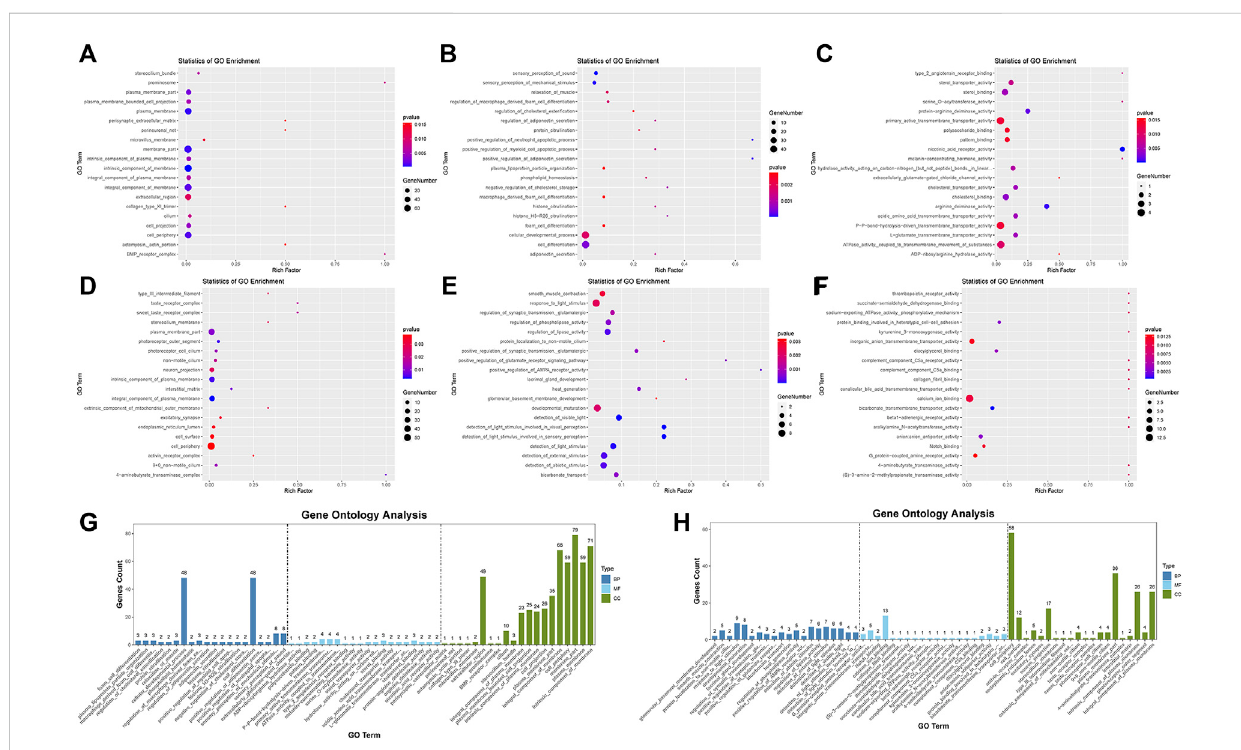
FIGURE 6 Results of gene ontology enrichment analysis. (A,B,C) Scatter plots show the top 20 signi fi cantly enriched gene ontology (GO) terms for the top 20 downregulated genes in three different functional groups of cellular components (CC), biological processes (BP), and molecular functions (MF) after JZTX-14 treatment of MDA-MB-231 cells. (D,E,F) Scatter plots show the top 20 signi fi cantly enriched gene ontology (GO) terms for the top 20 upregulated genes in CC, BP, and MF after JZTX-14 treatment of MDA-MB-231 cells. (G) GO terms for the top 20 signi fi cantly enriched downregulated genes in three different functional groups. (H) GO terms for the top 20 signi fi cantly enriched upregulated genes in three different functional groups. Dark blue indicates BP, light blue indicates MF, and green indicates